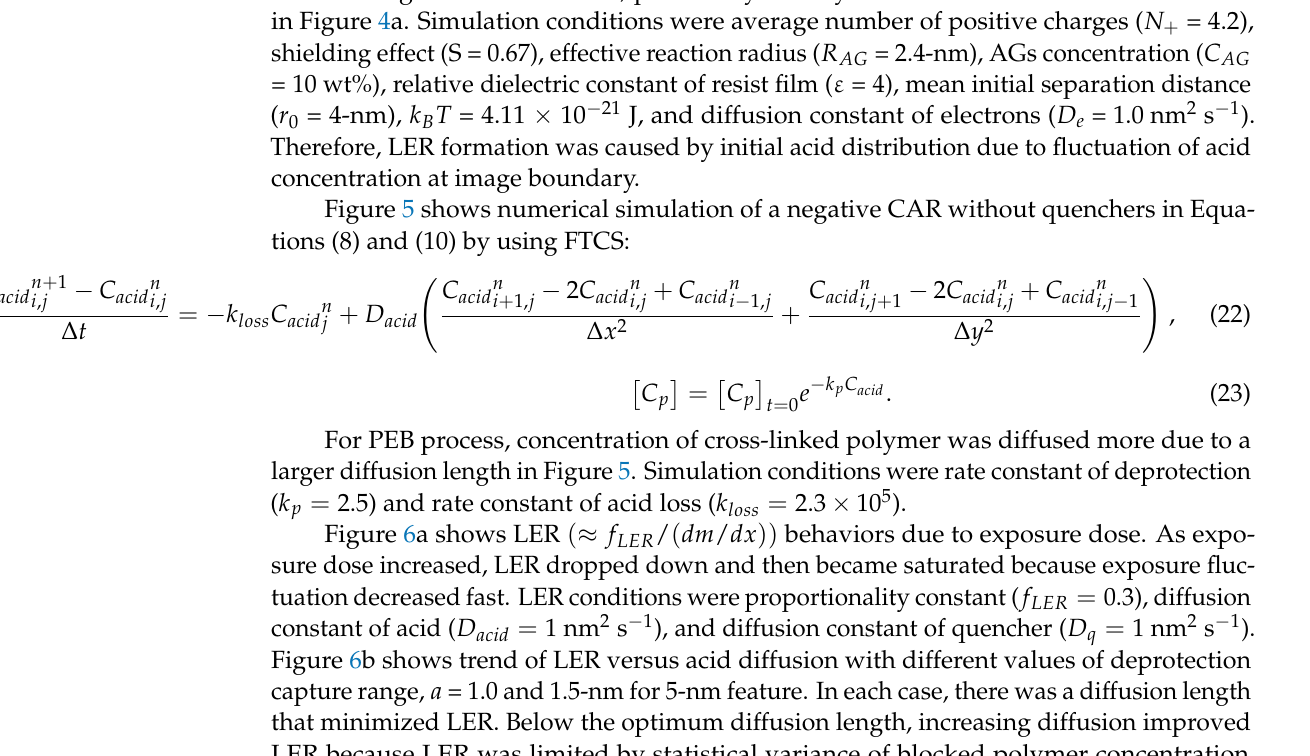
= 10 wt% ), relative dielectric constant of resist film ( ε = 4), mean initial separation distance